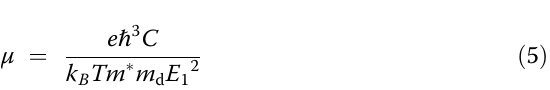
Figure S1. The calculated deformation potential E 6.13 eV (6.14 eV) for electron along x ( y ) direction, and 3.45 eV (3.33 eV) for hole along x ( y ) direction. The cal-